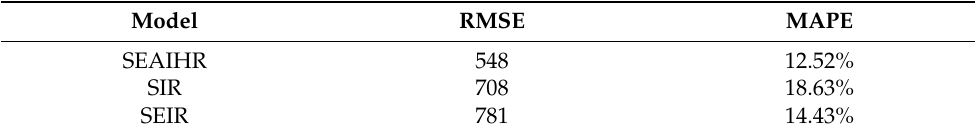
Figure 8. Simulation results comparison of stage 3. Table 7. Model evaluation in stage 3.